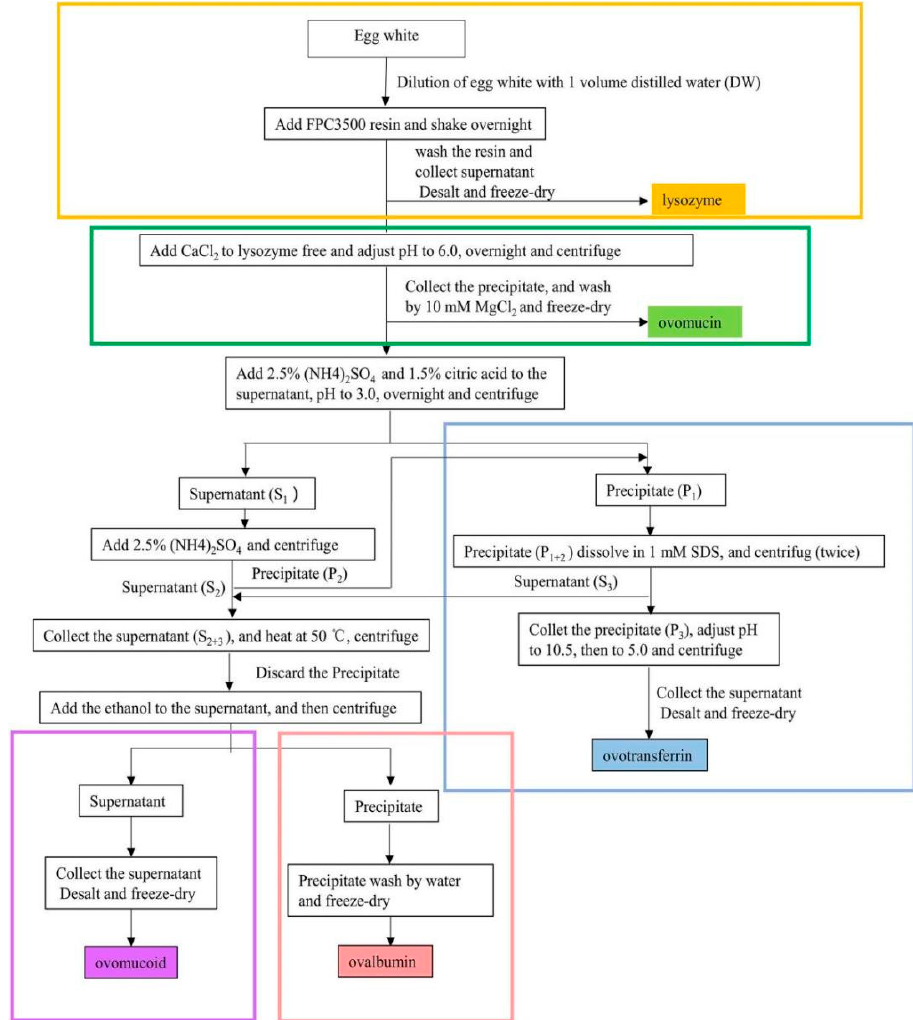
Figure 1. Flow chart of the co-purification process by Ji et al. [94].The different color boxes represent the key extraction processes for each protein.